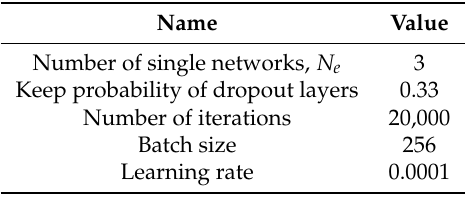
Table 1. Hyperparameters used in the training process.